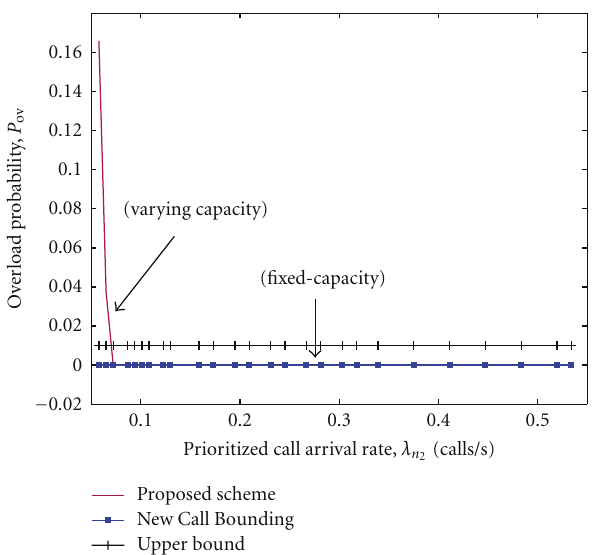
Figure 8: Overload probability versus prioritized call arrival